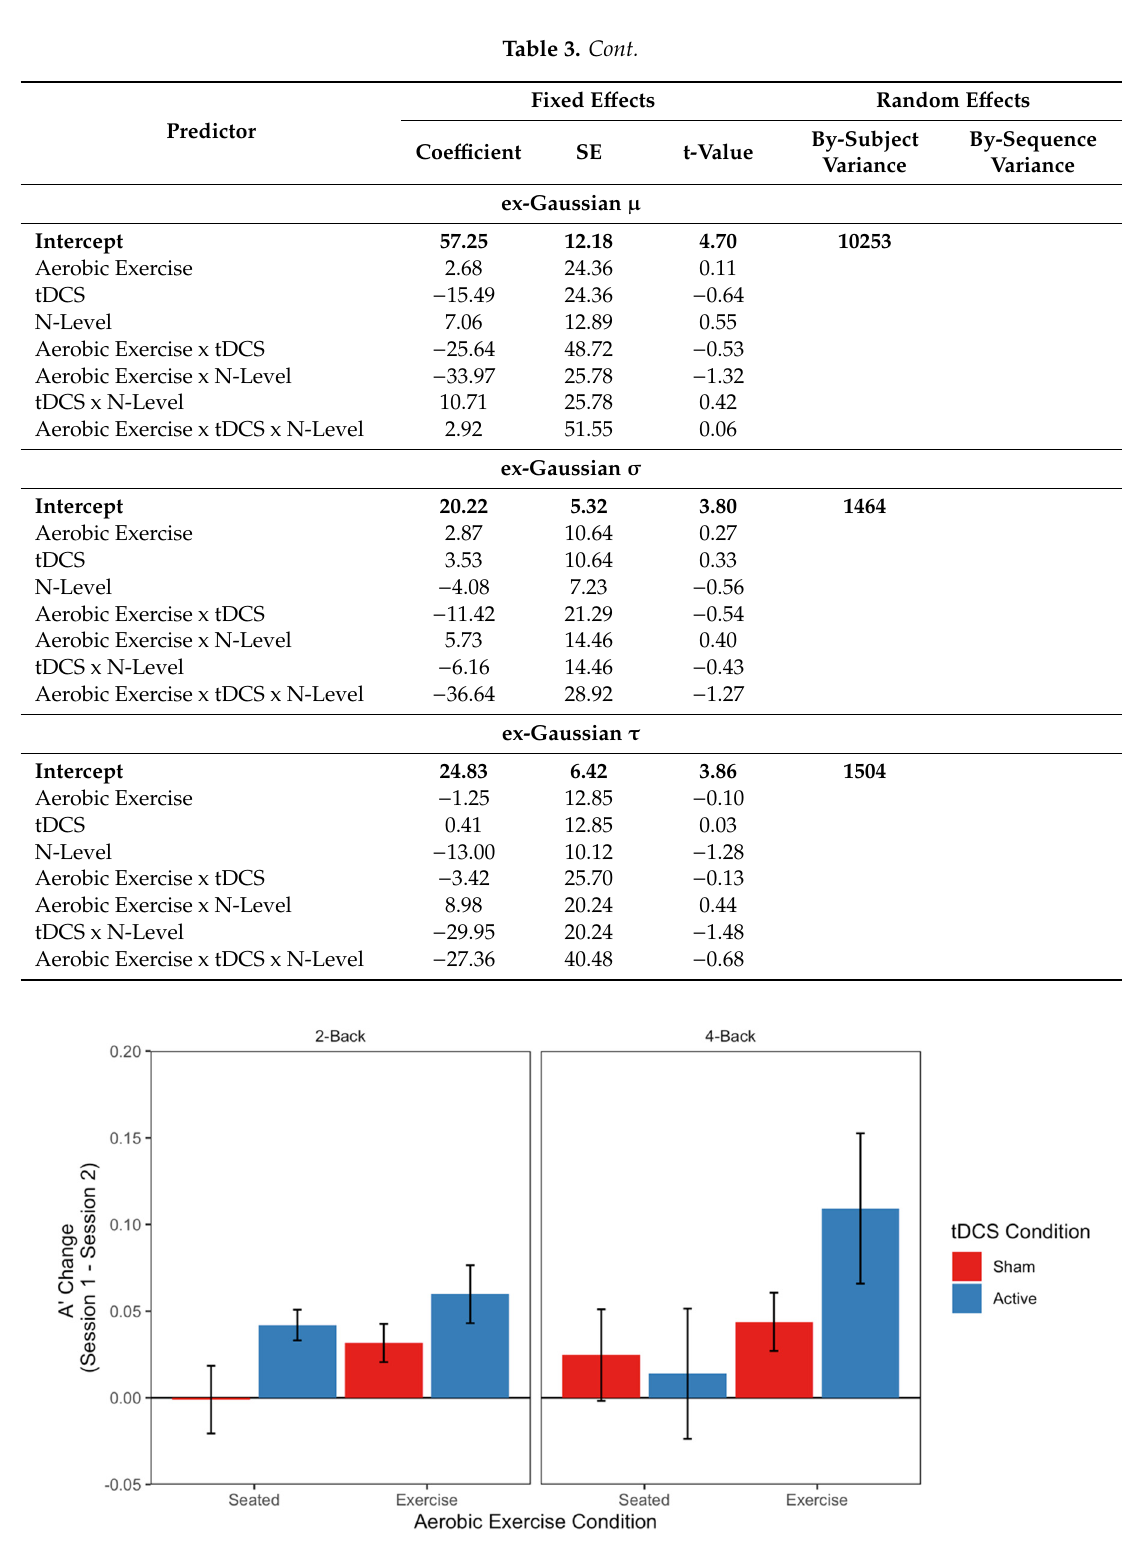
Figure 3. Target/nontarget discriminability ( A’ ) on the n-back task. Bars depict average differences between Sessions 1 and 2 for each Aerobic Exercise Condition (Seated vs. Exercise, leftmost and rightmost bars of each panel, respectively) and tDCS Condition (Active vs. Sham, in Blue and Red, respectively). Split across two panels is N-Level (2-Back vs. 4-Back, on the left and right, respectively). Error bars reflect standard errors of the mean.